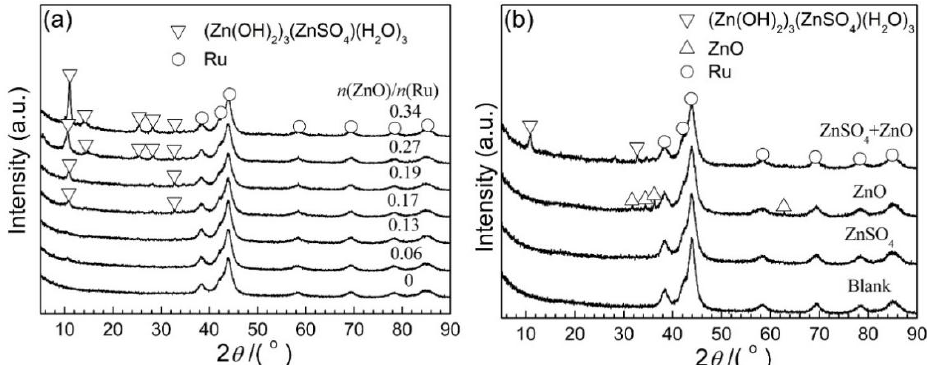
Figure 1. XRD patterns of the Ru-4.7 catalyst with different additives after catalytic experiments. ( a ) by adding different content of ZnO in the presence of ZnSO 4 (0.62 mol·L ‒ 1 ); ( b ) with addition of only ZnO (n(ZnO)/n(Ru) = 0.19), only ZnSO 4 (0.62 mol·L ‒ 1 ), both ZnO (n(ZnO)/n(Ru) = 0.19) and ZnSO 4 (0.62 mol·L ‒ 1 ) or without any additives.